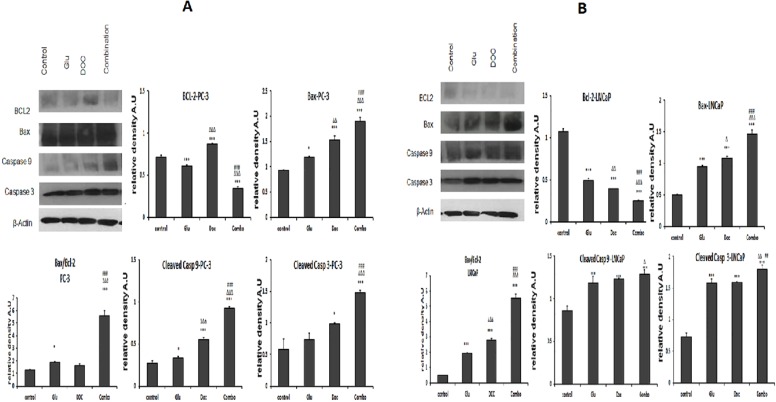
(A) The effect of GLU, DOC and their combination on the expression of mitochondrial apoptosis signaling proteins in PC-3 prostate cancer cells.(∗) Significantly different than the control at P < 0.05 (∗∗) significantly different compared to the control at P < 0.01. (∗∗∗) significantly different compared to the control at P < 0.001. (\documentclass[12pt]{minimal}
\usepackage{amsmath}
\usepackage{wasysym}
\usepackage{amsfonts}
\usepackage{amssymb}
\usepackage{amsbsy}
\usepackage{upgreek}
\usepackage{mathrsfs}
\setlength{\oddsidemargin}{-69pt}
\begin{document}
}{}$\mrm{\Delta }$\end{document}Δ) significantly different compared to GLU at P < 0.05. (\documentclass[12pt]{minimal}
\usepackage{amsmath}
\usepackage{wasysym}
\usepackage{amsfonts}
\usepackage{amssymb}
\usepackage{amsbsy}
\usepackage{upgreek}
\usepackage{mathrsfs}
\setlength{\oddsidemargin}{-69pt}
\begin{document}
}{}$\mrm{\Delta }\mrm{\Delta }$\end{document}ΔΔ) significantly different compared to GLU at P < 0.01. (\documentclass[12pt]{minimal}
\usepackage{amsmath}
\usepackage{wasysym}
\usepackage{amsfonts}
\usepackage{amssymb}
\usepackage{amsbsy}
\usepackage{upgreek}
\usepackage{mathrsfs}
\setlength{\oddsidemargin}{-69pt}
\begin{document}
}{}$\mrm{\Delta }\mrm{\Delta }\mrm{\Delta }$\end{document}ΔΔΔ) significantly different compared to GLU at P < 0.001. (#) Significantly different than DOC at P < 0.05. (##) significantly different compared to DOC at P < 0.01. (###) significantly different compared to DOC at P < 0.00. Data are means ± SD (n = 3) of relative band densities normalized to β-actin content. (B) The effect of GLU, DOC and their combination on the expression of many cell survival and apoptotic pathways in LNCaP prostate cancer cells. (∗) Significantly different than the control at P < 0.05 (∗∗) significantly different from the control at P < 0.01. (∗∗∗) significantly different compared to the control at P < 0.001. (\documentclass[12pt]{minimal}
\usepackage{amsmath}
\usepackage{wasysym}
\usepackage{amsfonts}
\usepackage{amssymb}
\usepackage{amsbsy}
\usepackage{upgreek}
\usepackage{mathrsfs}
\setlength{\oddsidemargin}{-69pt}
\begin{document}
}{}$\mrm{\Delta }$\end{document}Δ) significantly different compared to GLU at P < 0.05. (\documentclass[12pt]{minimal}
\usepackage{amsmath}
\usepackage{wasysym}
\usepackage{amsfonts}
\usepackage{amssymb}
\usepackage{amsbsy}
\usepackage{upgreek}
\usepackage{mathrsfs}
\setlength{\oddsidemargin}{-69pt}
\begin{document}
}{}$\mrm{\Delta }\mrm{\Delta }$\end{document}ΔΔ) significantly different compared to GLU at P < 0.01. (\documentclass[12pt]{minimal}
\usepackage{amsmath}
\usepackage{wasysym}
\usepackage{amsfonts}
\usepackage{amssymb}
\usepackage{amsbsy}
\usepackage{upgreek}
\usepackage{mathrsfs}
\setlength{\oddsidemargin}{-69pt}
\begin{document}
}{}$\mrm{\Delta }\mrm{\Delta }\mrm{\Delta }$\end{document}ΔΔΔ) significantly different compared to GLU at P < 0.001. (#) Significantly different than DOC at P < 0.05. (##) significantly different compared to DOC at P < 0.01. (###) significantly different compared to DOC at P < 0.001. Data are means ± SD (n = 3) of relative band densities normalized to β-actin content.